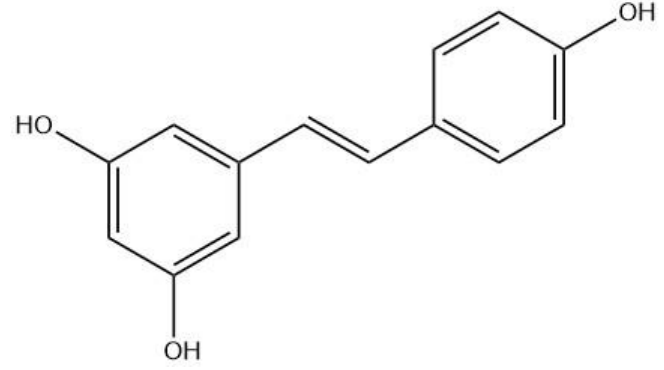
Figure 1. Chemical structure of resveratrol (3,5,4’‑trihydroxystilbene).